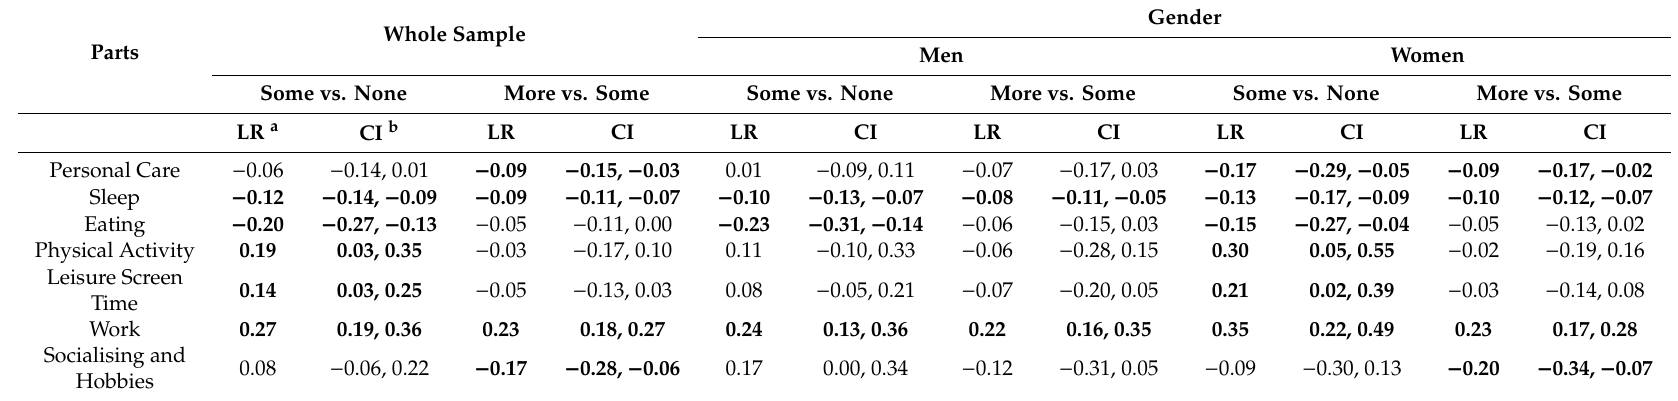
Table A3. Log-ratio di ff erence between groups and bootstrapped confidence